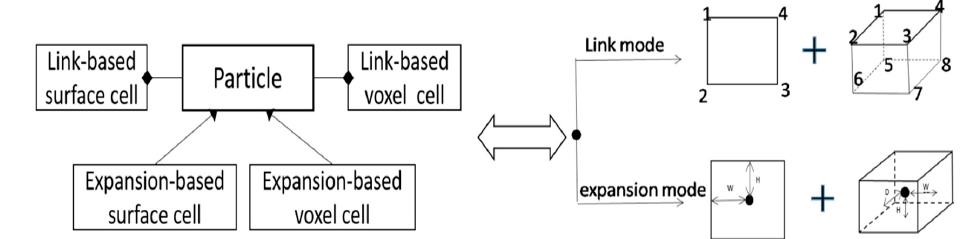
Figure 8. Data structure framework for the realization of the spatial lattice model.